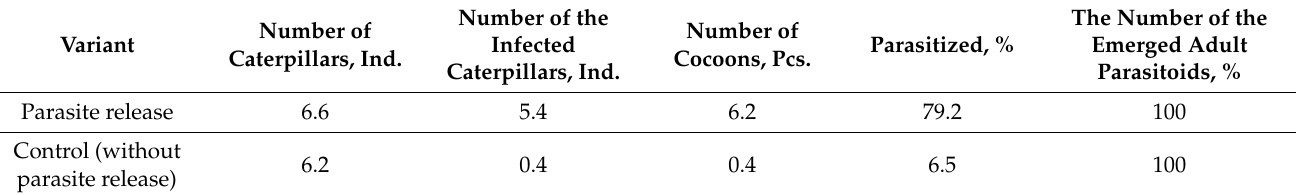
Table 7. The number of the infected caterpillars in trapping